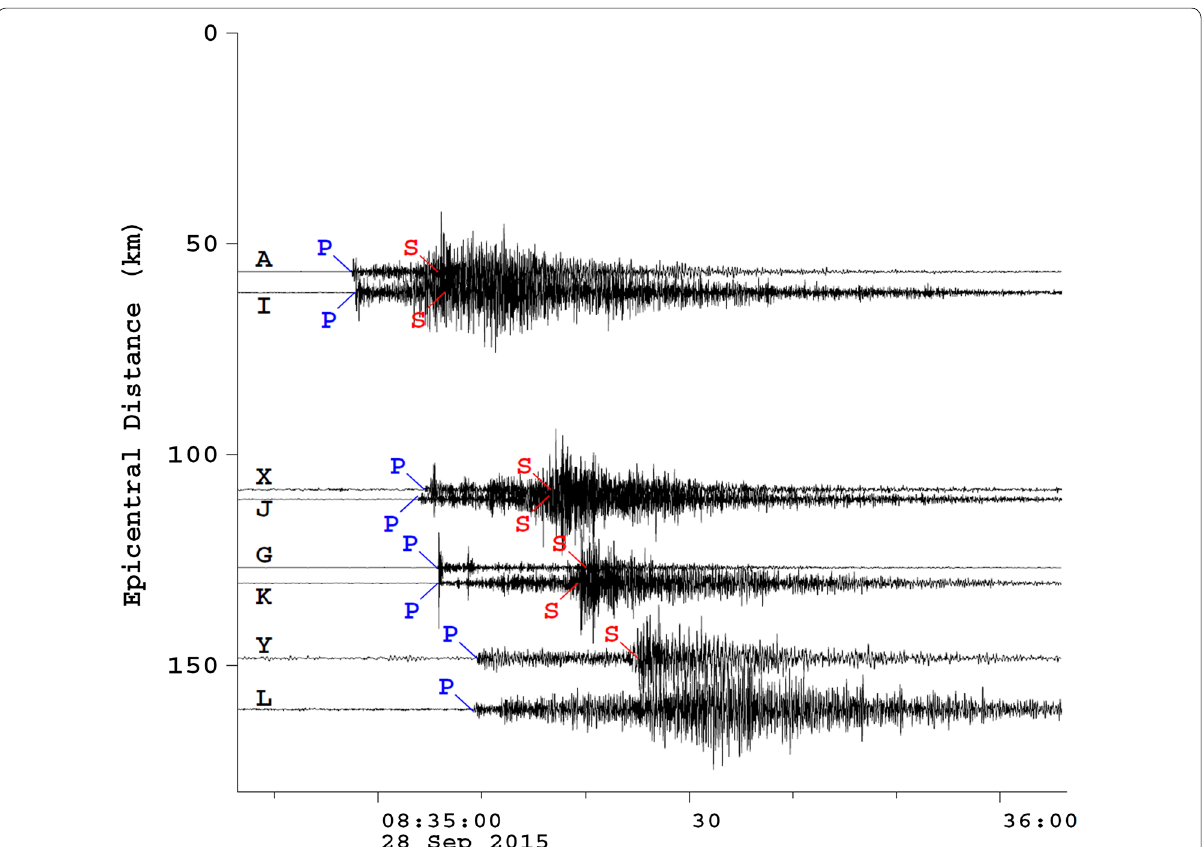
Fig. 5 Vertical seismic records of an earthquake in the mantle wedge, with the P- and S-wave arrival time picks used for hypocenter determination